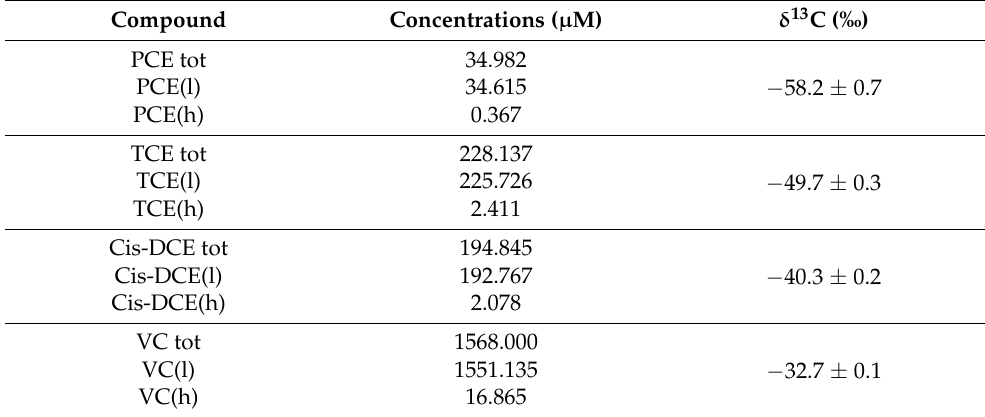
Table 4. Concentrations and isotopic compositions used to model the plume source in the PHREEQC